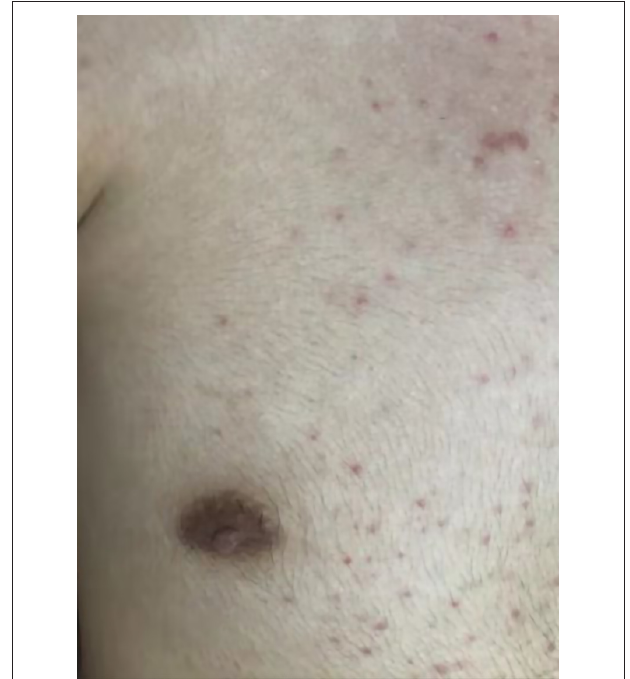
FIGURE 1 | Erythema rash on the front of the